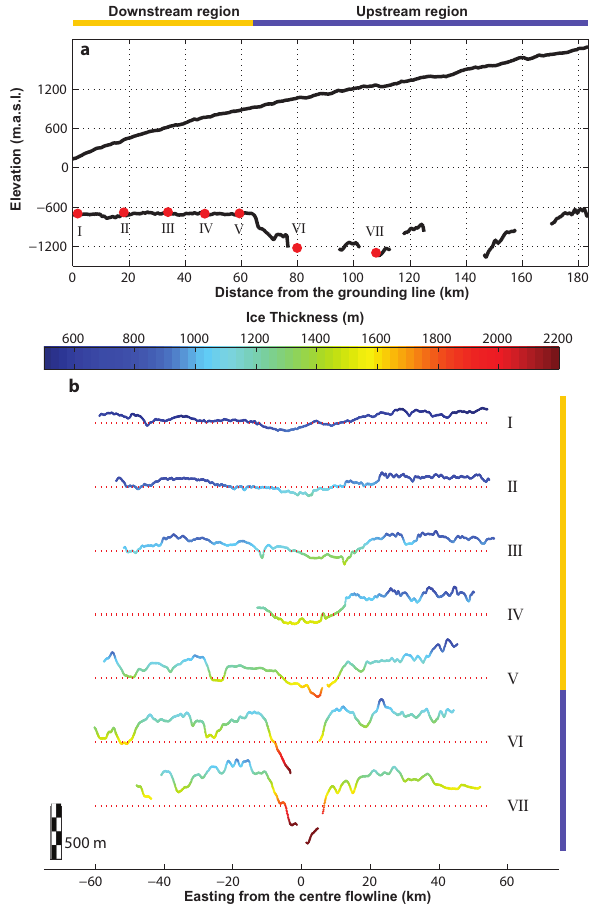
Fig. 2. Radar data. (a) Ice and bed topography along the cen- 20 tral flowline. The red circles are the locations of the cross pro- files. (b) Bed topography (ordinate) and ice thickness (colour) measured across the flow. The red dotted lines show the isodepth of 600mb.s.l., the approximate elevation of the flat basin mea- sured along the centre flowline (a) and the reference for each pro- file.Transverse profiles are numbered from I to VII on both panels. The yellow and blue line illustrates our understanding of the down- stream and upstream